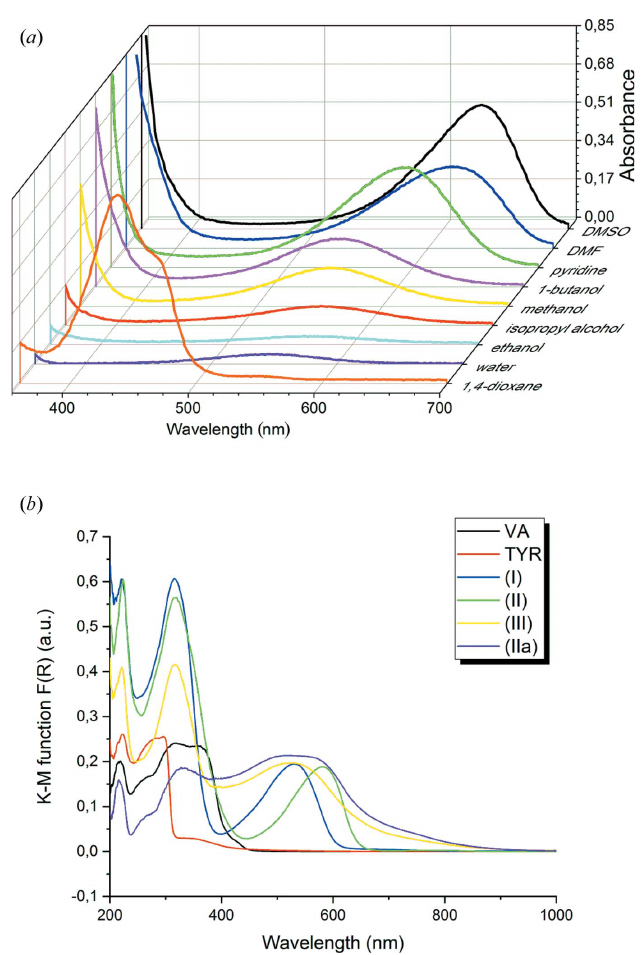
Figure 6 UV–Vis spectra of tyraminium violurate ( a ) in selected solvents, and ( b ) in solid-state samples of (I), (II), (III) and (II a ) in comparison with TYR and VA monohydrate.